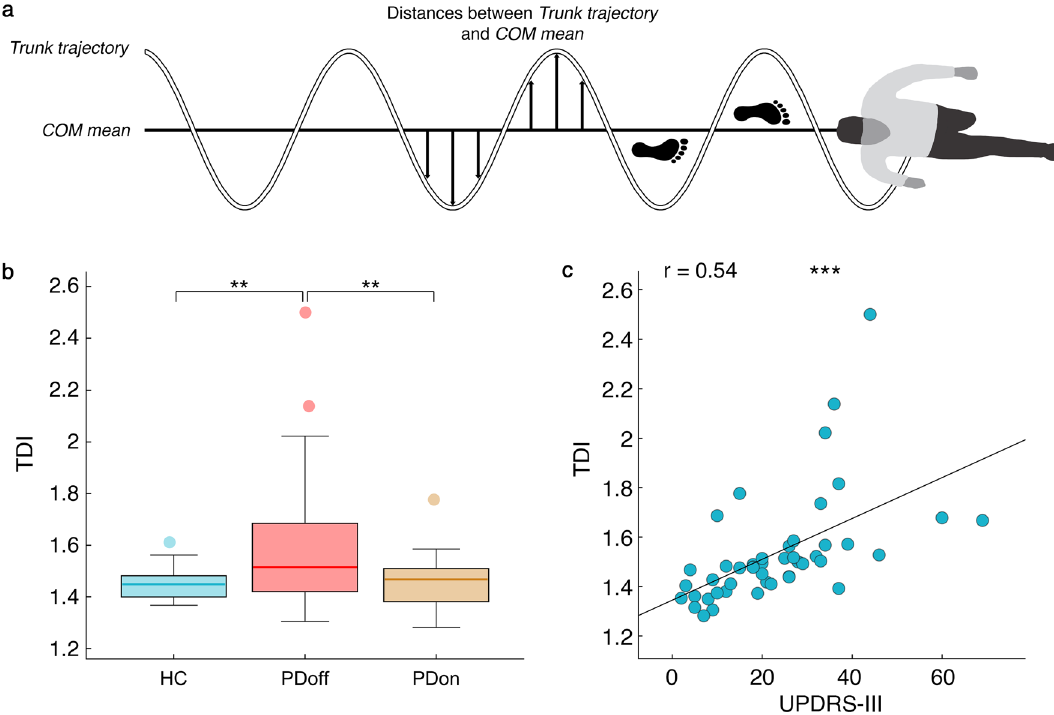
Figure 2. Trunk displacement index (TDI) . ( a ). The graphical representation of a step of the TDI calculation. The horizontal line is the mean position of the centre of mass on the x axis (COM mean). The waving line is the trajectory of the trunk. The arrows represent the distance between trunk trajectory and COM mean in each frame. ( b ). The box plot (see Fig. 1 caption for explanation of box plot) of the TDI comparison among healthy controls (HC), individual with Parkinson’s disease before L-DOPA intake (PDoff) and individual with Parkinson’s disease after L-DOPA intake (PDon). ( c ). The correlation between TDI and Unified Parkinson’s Disease Rating Scale Part III score (UPDRS-III), including PDoff and PDon. Significance p value: * p < 0.05, ** p < 0.01, *** p <